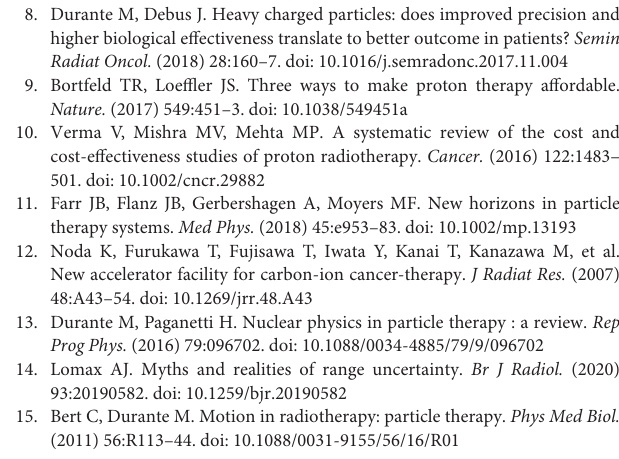
algorithm for correct identification of the different types of